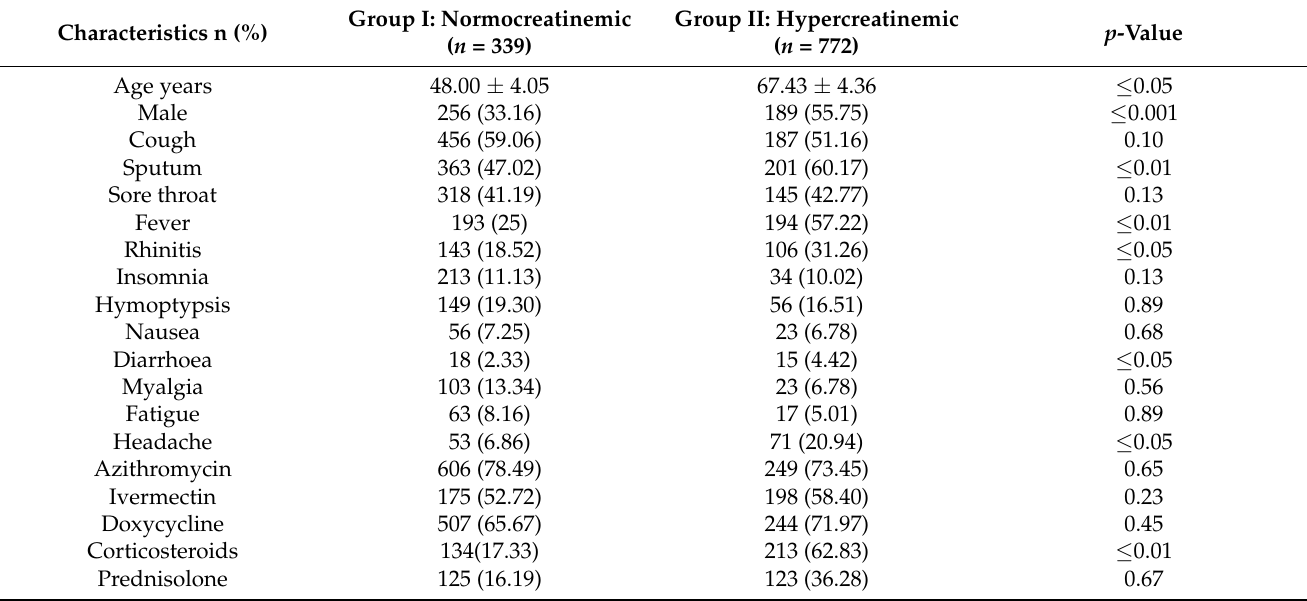
Table 2. Baseline characteristics of COVID-19 infected hypercreatinemic and normocreatinemic